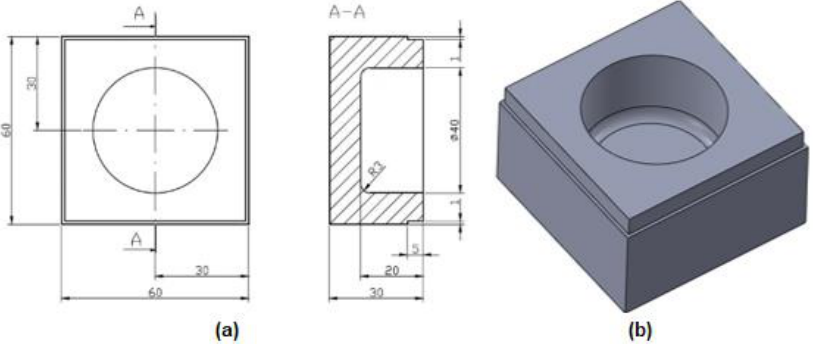
Figure 1. Test sample ( a ) dimensions of the test sample ( b ) 3D model.